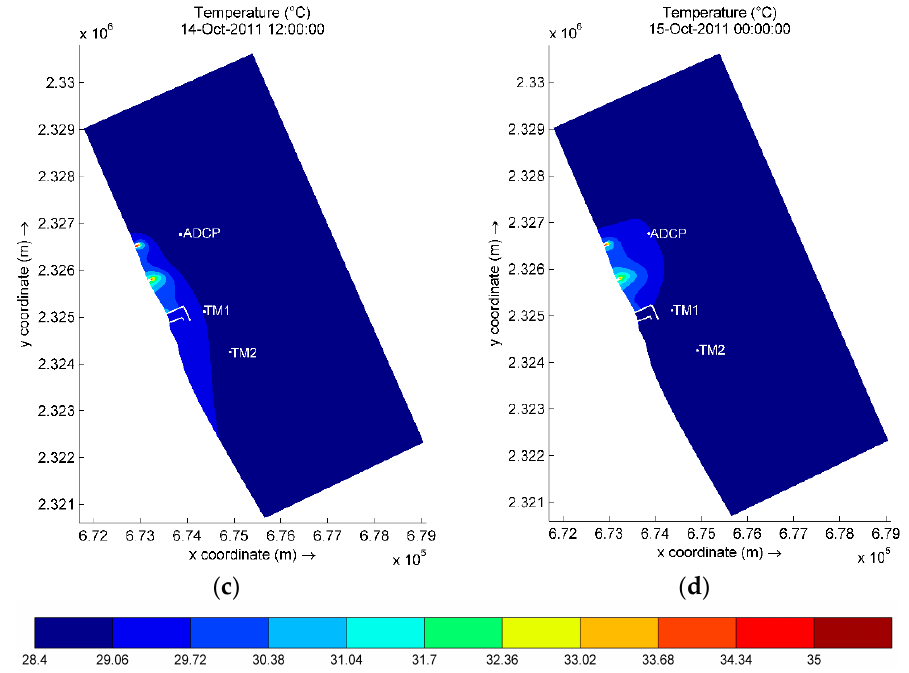
Figure 13. Temperature field (in °C) at time intervals of 12 h. ( a ) 13 October 2011 12:00:00; ( b ) 14 October 2011 00:00:00; ( c ) 14 October 2011 12:00:00; ( d ) 15 October 2011 00:00:00.